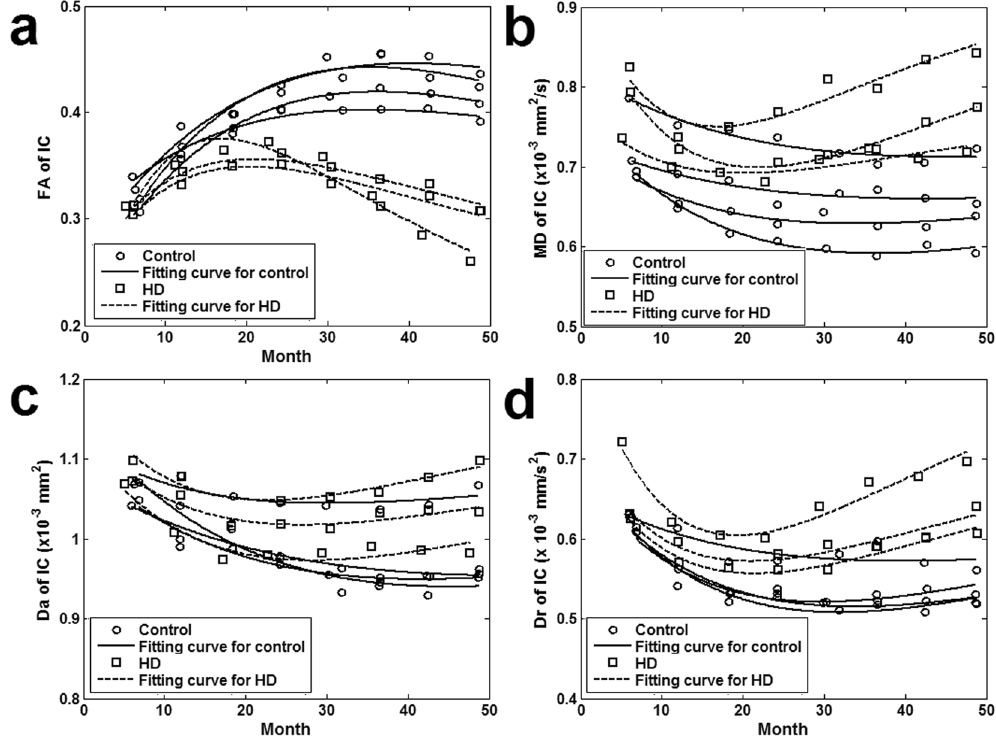
Figure 2. An illustration of the developmental changes of the DTI-derived measures across ages for the internal capsule (IC) of HD and control animals, fitted with the Poisson model. FA: fractional anisotropy; MD: mean diffusivity; Da: axial diffusivity; Dr: radial